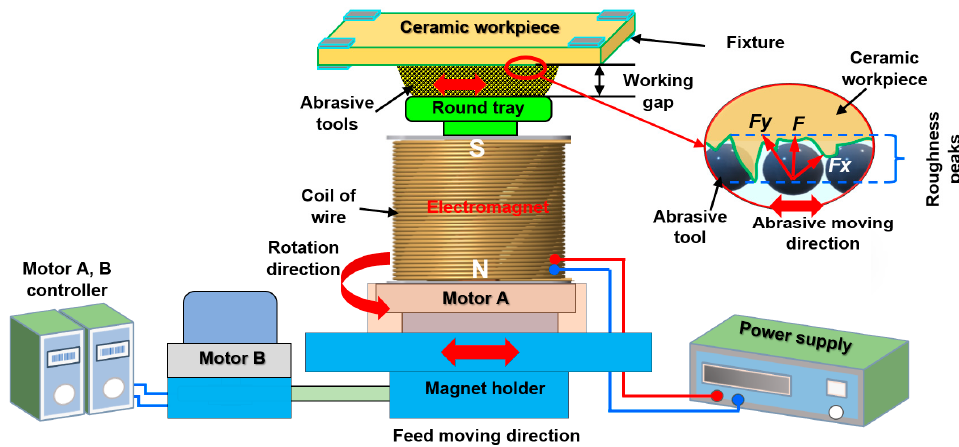
Figure 5. Schematic of a plane magnetic abrasive finishing setup for a ceramic plate workpiece, redrawn from Zou et al. [54].